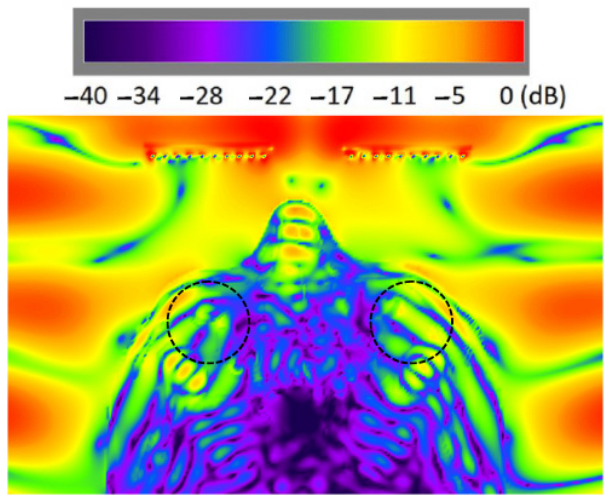
Figure 14. Power density distribution with shield (vertical polarization); reference value 0 dB = 40 W/m 2 . The regions in the circle are the areas of the eye.